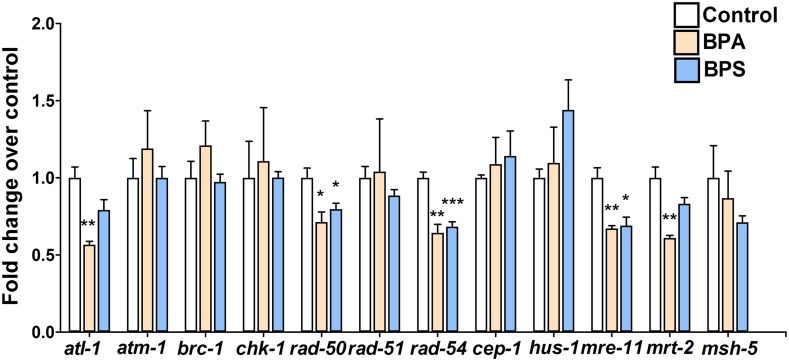
Distinct expression changes of genes implicated in DSBR and DNA damage checkpoints activation pathways.The expression levels of target genes were assayed from isolated germlines by quantitative RT-PCR. Error bars represent SEM for 3–4 biological replicates each tested in duplicate. Two-tailed Student’s t-test between vehicle control (0.1% ethanol) and each treatment group (500 μM BPA or BPS). *P<0.05, **P<0.01 and ***P<0.001.